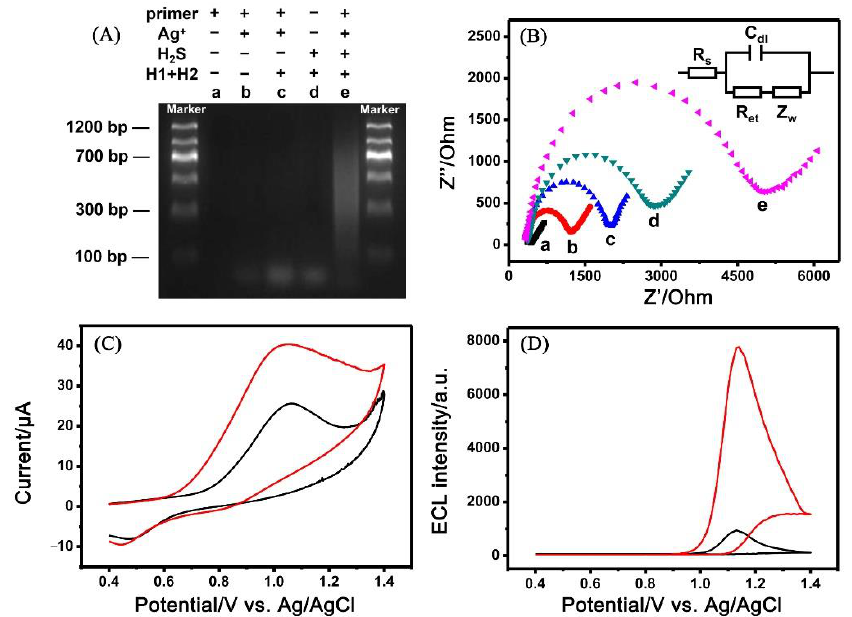
Figure 2. ( A ) Agarose gel electrophoresis (lane a: primer; lane b: primer + Ag + ; lane c: primer + Ag + + H1 + H2; lane d: H1 + H2; lane e: primer + Ag + + H 2 S + H1 + H2); ( B ) electrochemical impedance spectroscopy of various probes modified at the electrode (a: bare Au electrode; b: electrode ‘a’ + primer + Ag + ; c: electrode ‘b’ + MCH; d: electrode ‘c’ + H1 + H2; e: electrode ‘c’ + H 2 S + H1 + H2) in [Fe(CN) 6 ] 3 − /4 − (5 mM) containing KNO 3 (0.1 M) in the range of 10 − 2 to 10 6 Hz at an alternate voltage of 214 mV; ( C ) Cyclic voltammograms and ( D ) ECL intensity of the proposed biosensor in the absence (black curve) and presence (red curve) of H 2 S (2 µ M) in Tris–HClO 4 buffer. The scan rate was 100 mV/s with